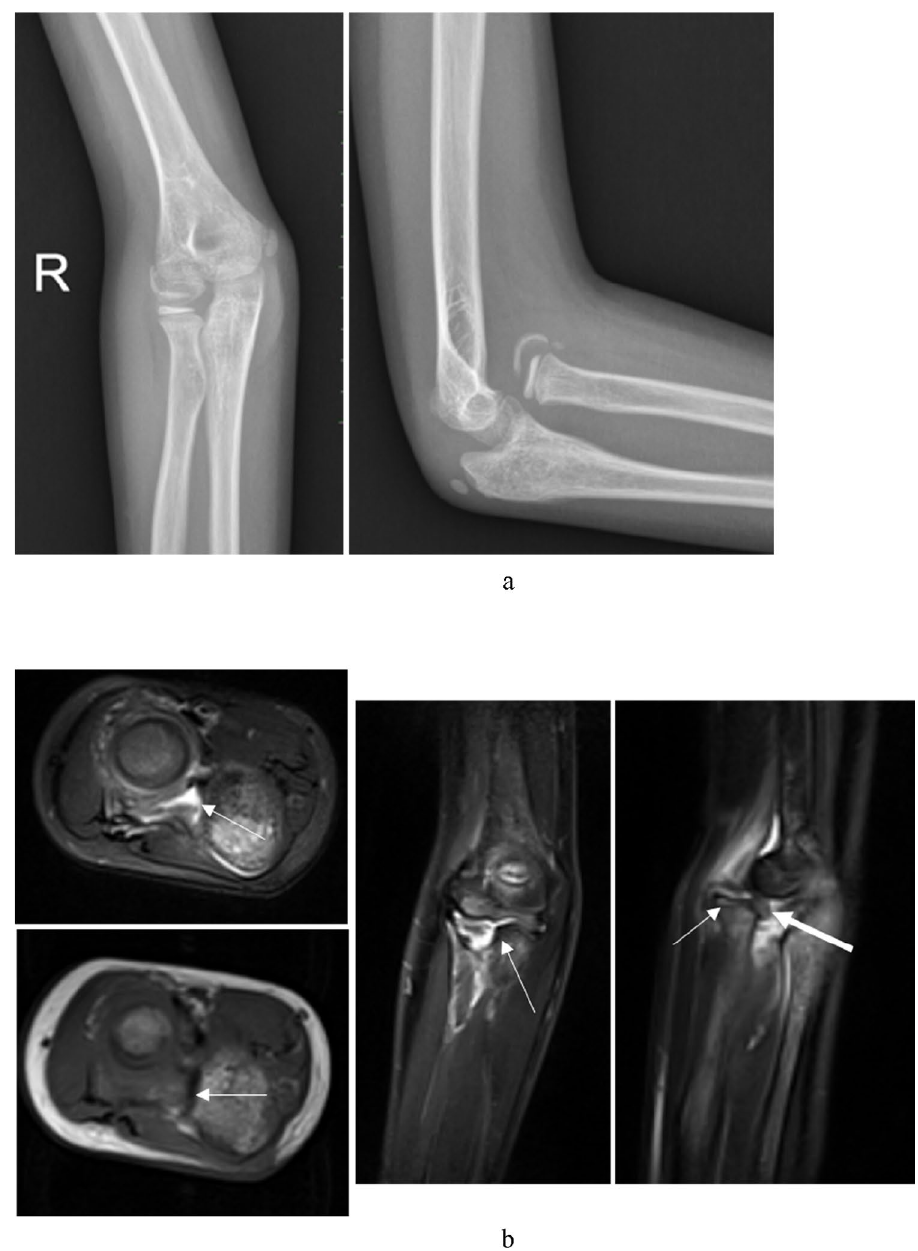
Figure 1. A 9 years old girl (case 4) had fallen from chair. She underwent treatment for a chronic Monteggia fracture after 1 month. ( a ) Preoperative X-ray. Heterotopic ossification can be seen. ( b ) Preoperative MRI. Axial T1- and T2-weighted images demonstrated the dislocation of the proximal radioulnar joint; axial and coronal T2-weighted images showed the concave radial notch of the ulna (the arrow); sagittal T2-weighted images displayed the dislocation of the humeroradial joint and the concave radial head (the thin arrow) combined with the folded and tortuousness annual ligament (the gross arrow). ( c ) Open reduction with ulnar osteotomy was undertaken. ( d ) The radial head remained concentric (Grade 1) and heterotopic ossification disappeared at 1 years after